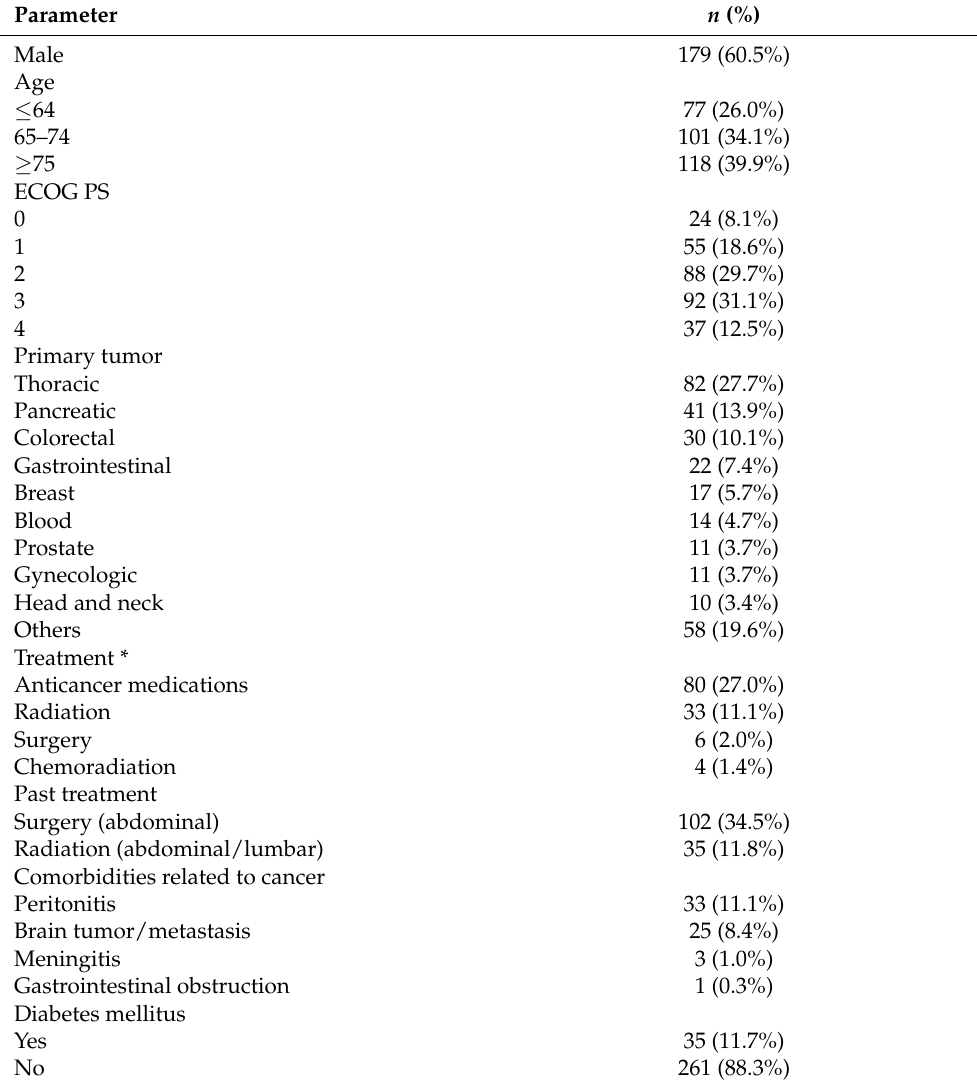
Table 1. Patient demographic and baseline characteristics cited.